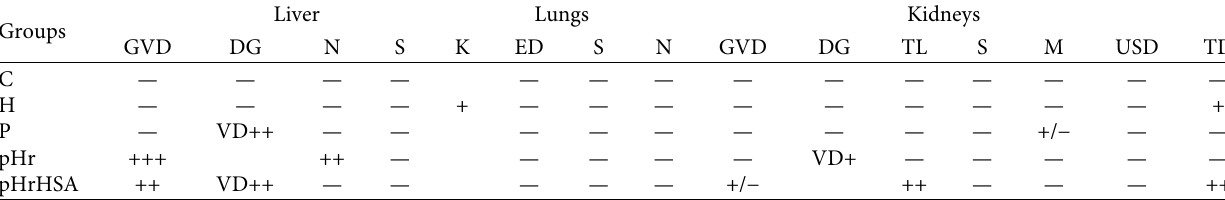
Table 2: Summary of histological fndings of transfusion experiments in the present study. Liver Groups